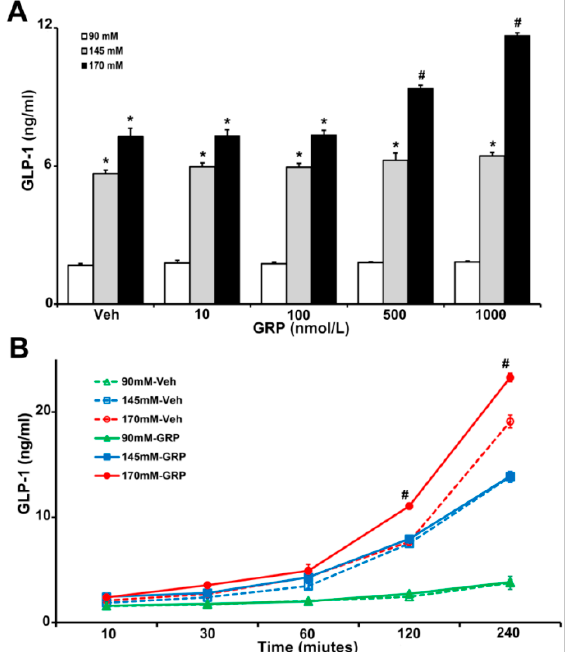
Figure 2. The effect of varying concentrations sodium (NaCl) and GRP on GLP-1 secretion in L-cells. The same quantity of cells were exposed to 90 mM, 145 mM, or 170 mM NaCl, and ( A ), treated with varying concentrations of GRP (10, 100, 500, and 1000 nmol/L) for 4 h, or ( B ), treated with 1000 nmol/L GRP for 30-, 60-, 120-, and 240-min. Vehicle (Veh) served as control. * p < 0.05 vs. 90 mM, # p < 0.05 vs. all others, one-way ANOVA, Holm–Sidak test, n =